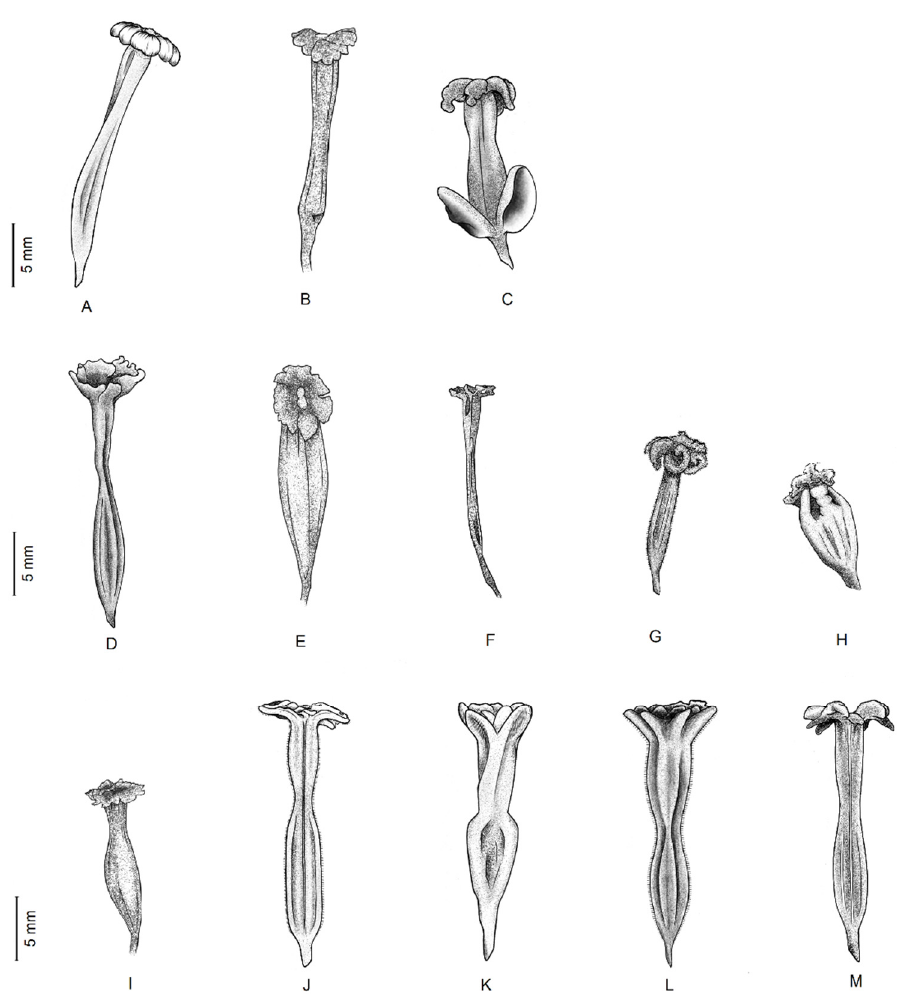
Figure 5. Perianth tubes of species and cultivars of Bougainvillea : basal taxa: ( A ) Bougainvil- lea peruviana , ( B ) B. pachyphylla ; ( C ) B. spinosa ; wild Bougainvillea : ( D ) B. stipitata , ( E ) B. infesta , ( F ) B. berberidifolia , ( G ) B. modesta , ( H ) B. campanulata ; cultivated Bougainvillea : ( I ) B. praecox , ( J ) B. glabra , ( K ) B. arborea , ( L ) B. spectabilis , and ( M ) B. cultivar. (Illustrated by Eingel Cannerie Jaramillo). Bougainvillea spinosa differs from other species of Bougainvillea by having forked or furcate thorns [8]. Moreover, the solitary flower surrounded by three bracts and the thick, fleshy leaves arranged into brachyblasts makes it more morphologically distinct from other species. Consequently, earlier classifications treated B. spinosa as a single species of subgenus Tricycla . The molecular analysis did not concur with this classification, but it clearly showed that B. spinosa does not have a close relationship with other species of Bou- gainvillea . It is also not the basal-most taxon but diverged earlier than the two major clades of Bougainvillea , the ‘cultivated’ Bougainvillea group (clade II) and the ‘wild’ Bougainvillea group (clade III).